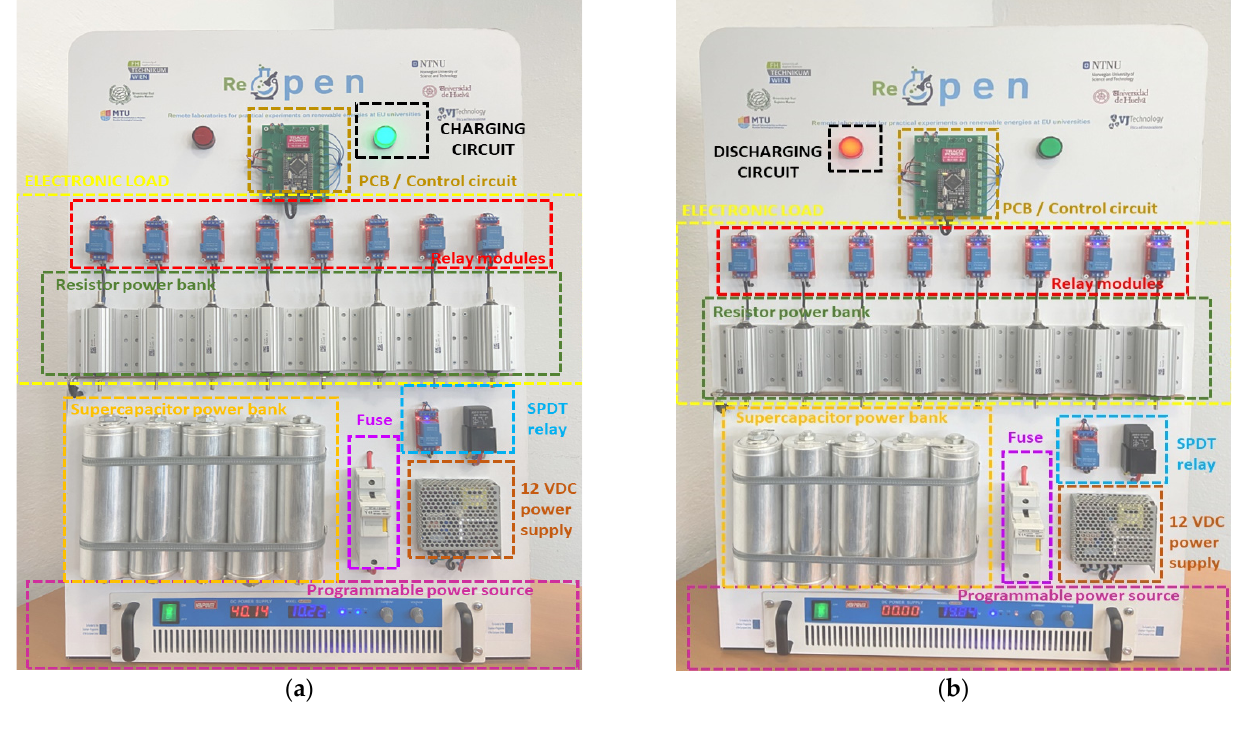
Figure 8. Physical implementation of the remote laboratory based on supercapacitor power bank: ( a ) charging process; ( b ) discharging process.